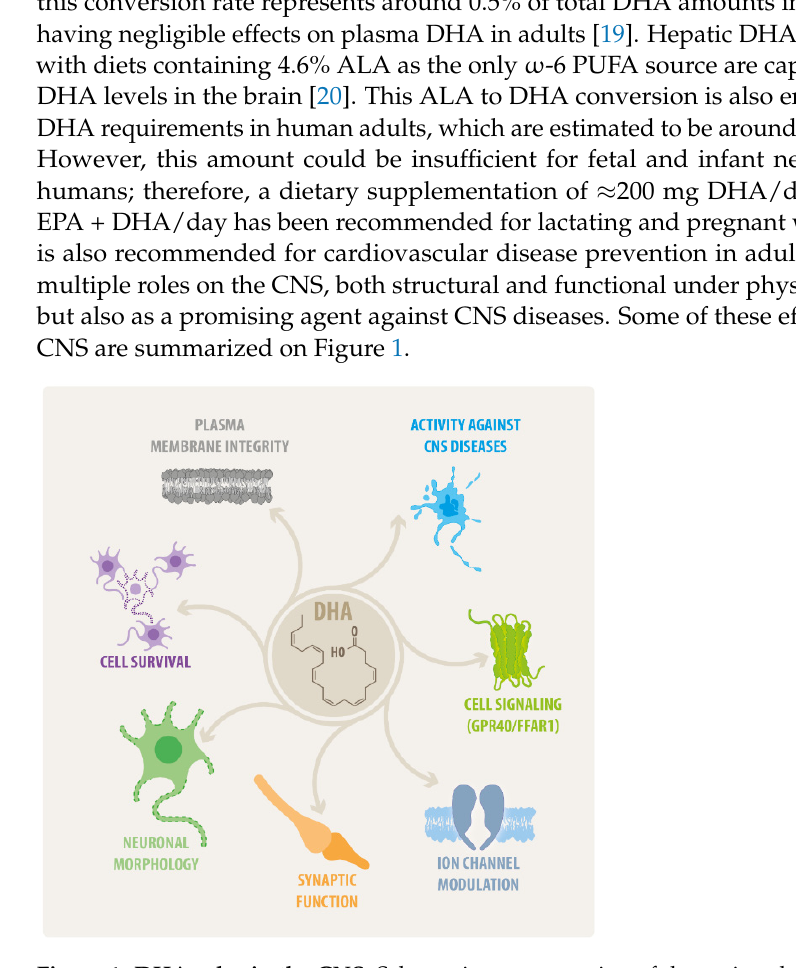
Figure 1. DHA roles in the CNS. Schematic representation of the main roles of DHA on the CNS, including structural, physiological, and therapeutic effects. Detailed information about these roles is properly developed on each section of this review.